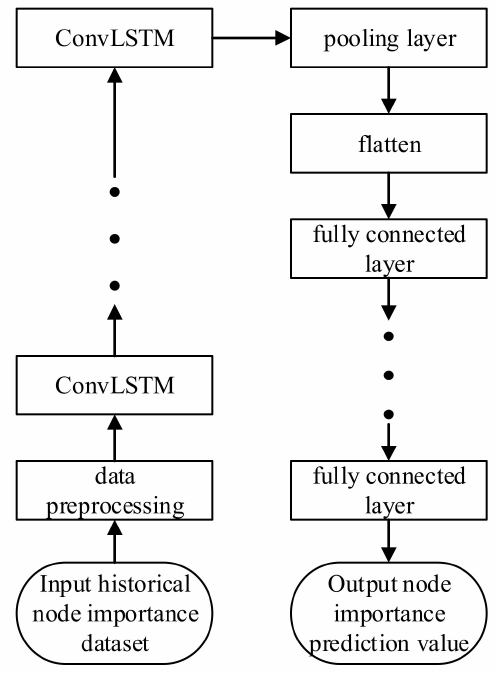
Figure 4. Deep ConvLSTM network